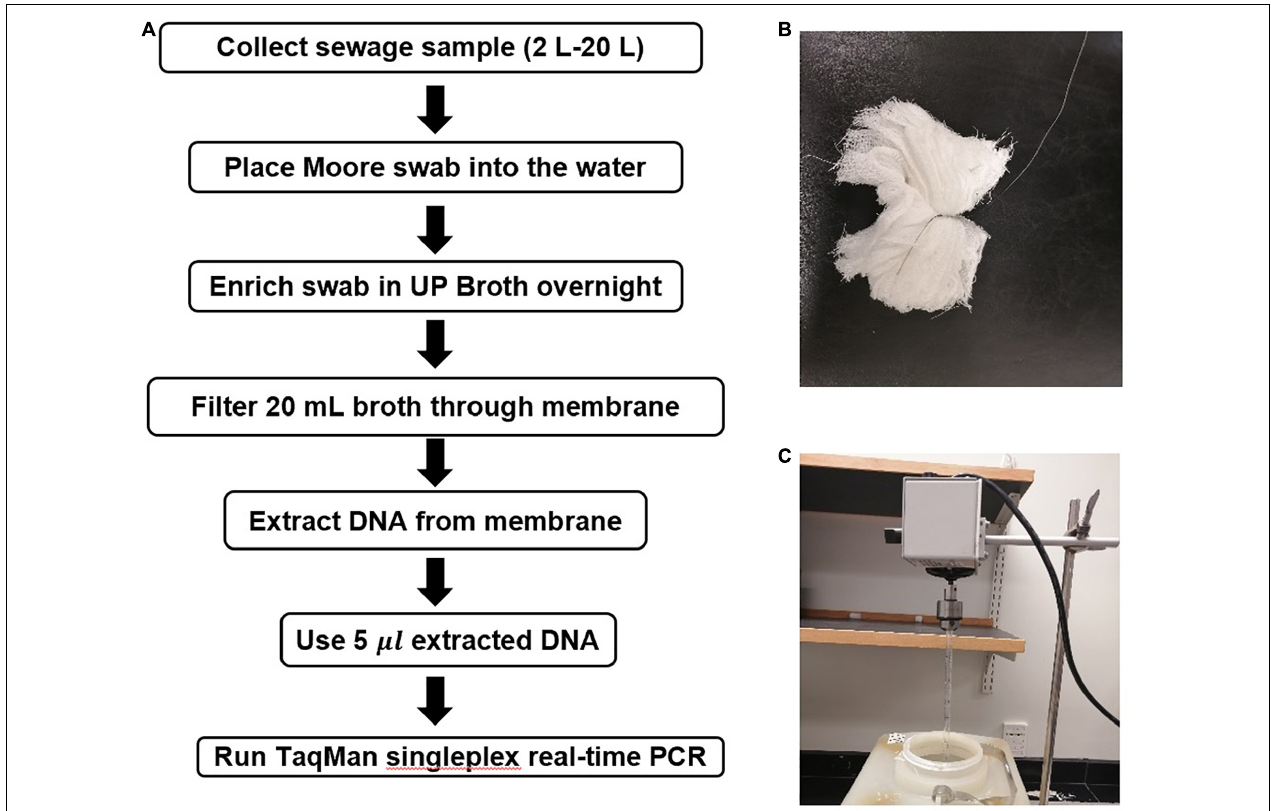
FIGURE 2 | Moore Swab method for recovering S. Typhi and S. Paratyphi. A from seeded sewage samples. (A) Flowchart for the Moore swab method validation experiments. (B) Moore swab. (C) Moore swab method laboratory setup for seeded sewage